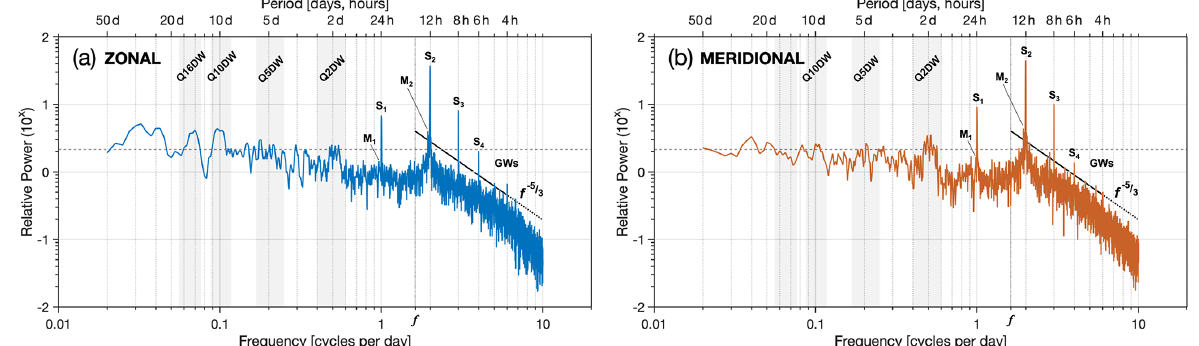
Figure 3. Normalised power spectra of the hourly zonal (a) and meridional (b) winds at 90km altitude measured by the South Georgia meteor radar for the period 2016 to 2020. Annotations show peaks corresponding to solar tides S 1–4 , lunar tides M 1–2 and planetary waves, where shaded grey regions for the latter show an approximate range of periods. The dashed horizontal line shows the 90% confidence level, f denotes the inertial period ( ∼ 14.8h) at 54 ◦ S, and the black line illustrates an idealised − 5 / 3 power law for gravity